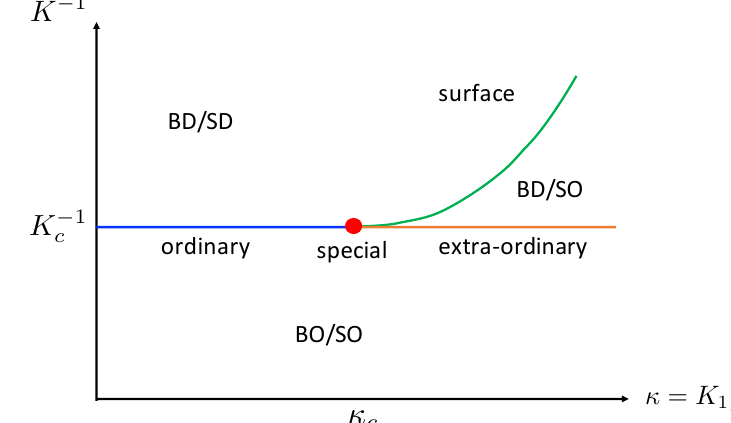
Figure 1: Conventionally accepted phase diagram of the classical O ( N ) model with a boundary in dimension d > 3. BO stands for bulk ordered, SO - surface ordered, BD - bulk disordered, SD - surface disordered. For d = 3 and N = 1 the phase diagram is the same. For d = 3 and N = 2 the phase diagram has the same topology, but the BD / SO region only has quasi-long-range surface